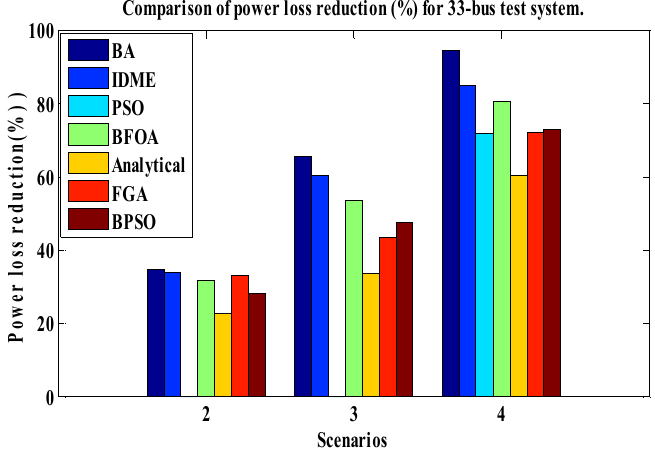
Figure 6. Comparison of VSI of 33-bus system at normal load.